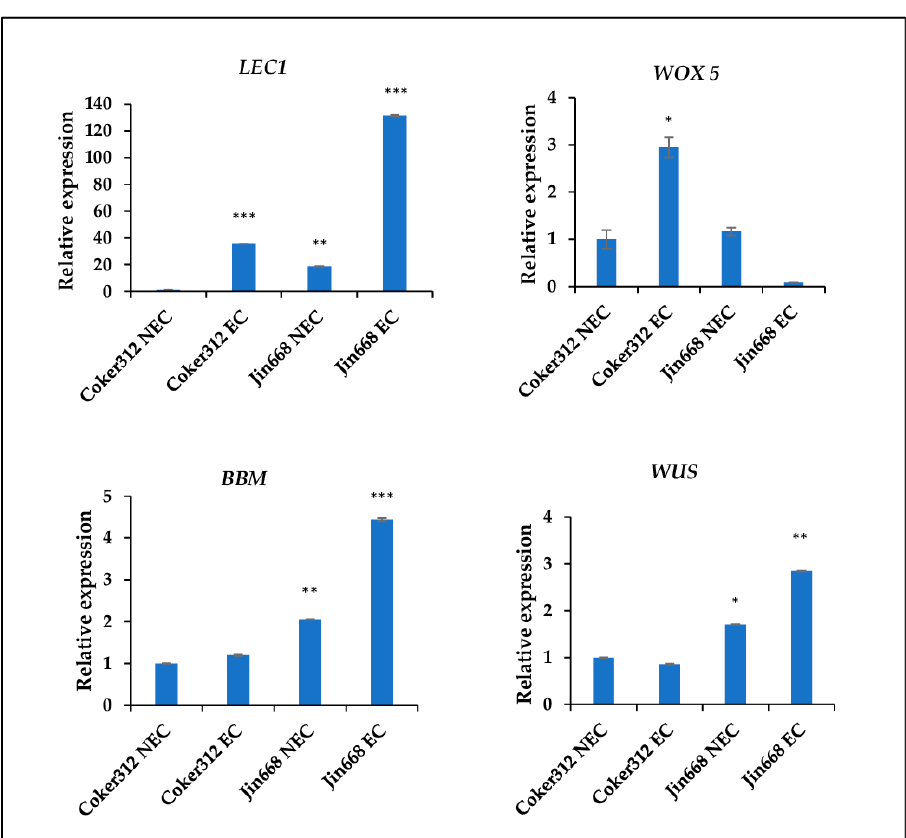
Figure 6. Expression of embryogenesis related gens in the non-embryogenic cells (NEC) and embryogenic cells (EC) of Coker312 and Jin668 by RT-qPCR analysis. The relative expressions of embryogenesis-related gens GhLEC1 , GhWOX5 , GhBBM , and GhWUS were measured. Three biological replicates and three technical replicates were used for statistical analysis. Error bars indicate ±SE (n = 3). The ΔΔ Ct method was used for qPCR analysis. Asterisks indicate statistically significant differences compared with the Coker312 NEC: Student’s t test; * p < 0.05; ** p < 0.01; *** p < 0.001.